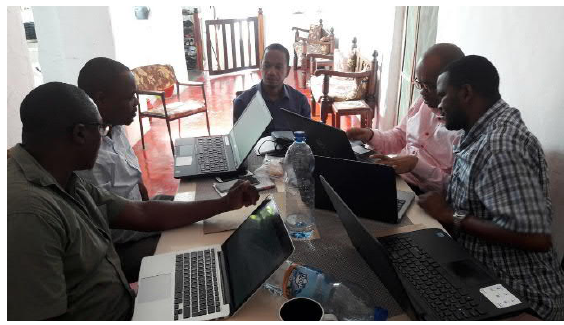
Figure 4. Curricula development meeting of SUZA team with UTU experts in Zanzibar (January 2018).